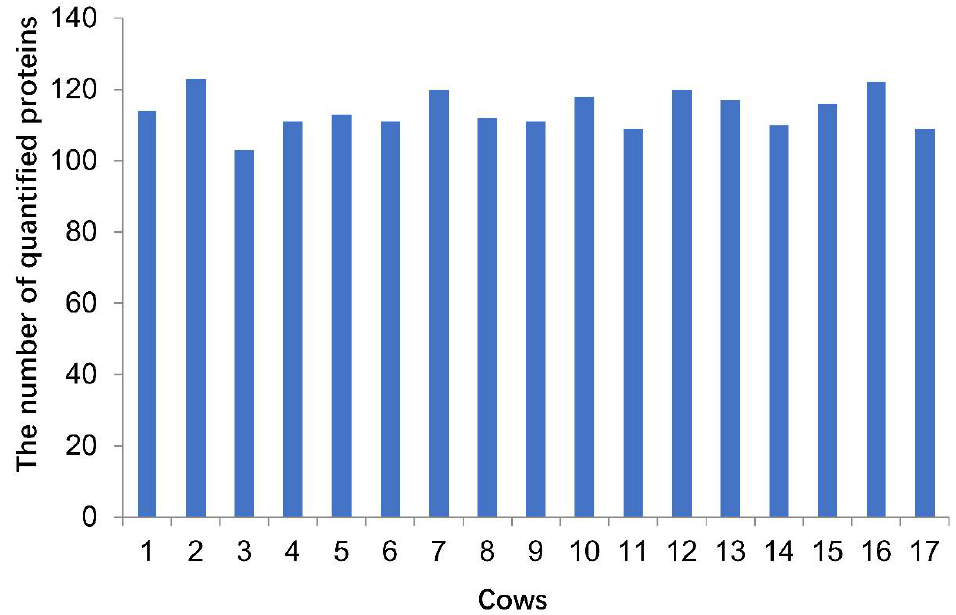
Figure 3. Number of quantified proteins in Sample Set 2 (17 cows, one timepoint, dimethyl labeled proteomics).